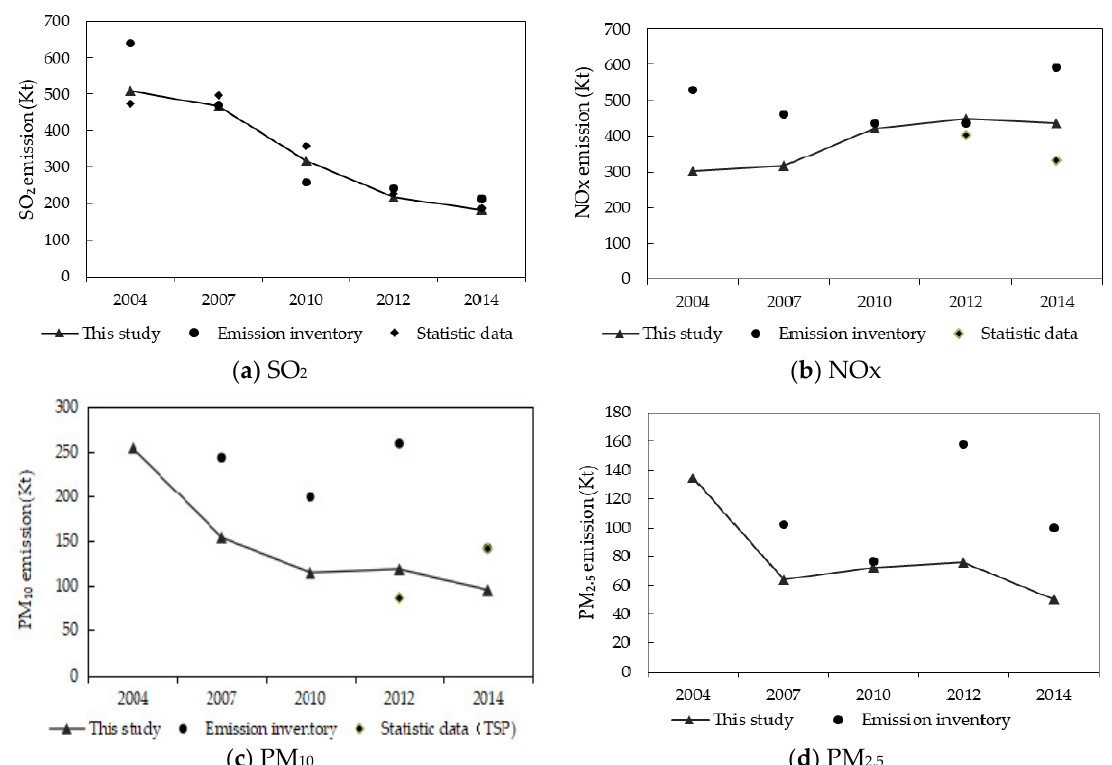
Figure 5. The comparison of local air pollutants simulation results and emission inventory data. ( a ) SO 2 ( b ) NOx ( c ) PM 10 ( d ) PM 2.5.